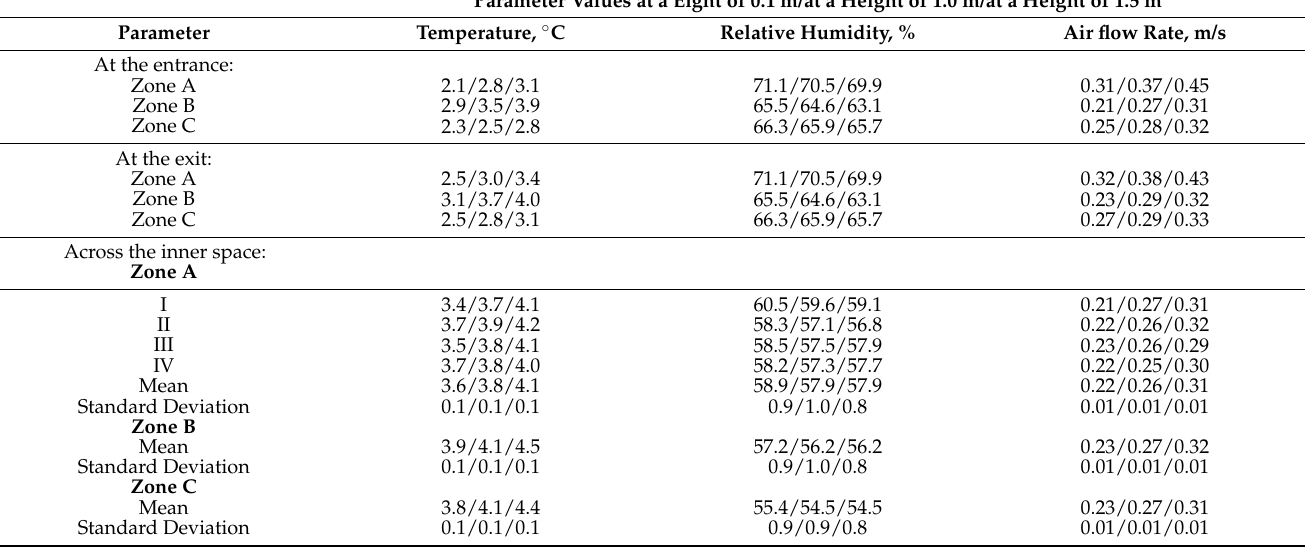
Table 3. Microclimate parameters in enclosed